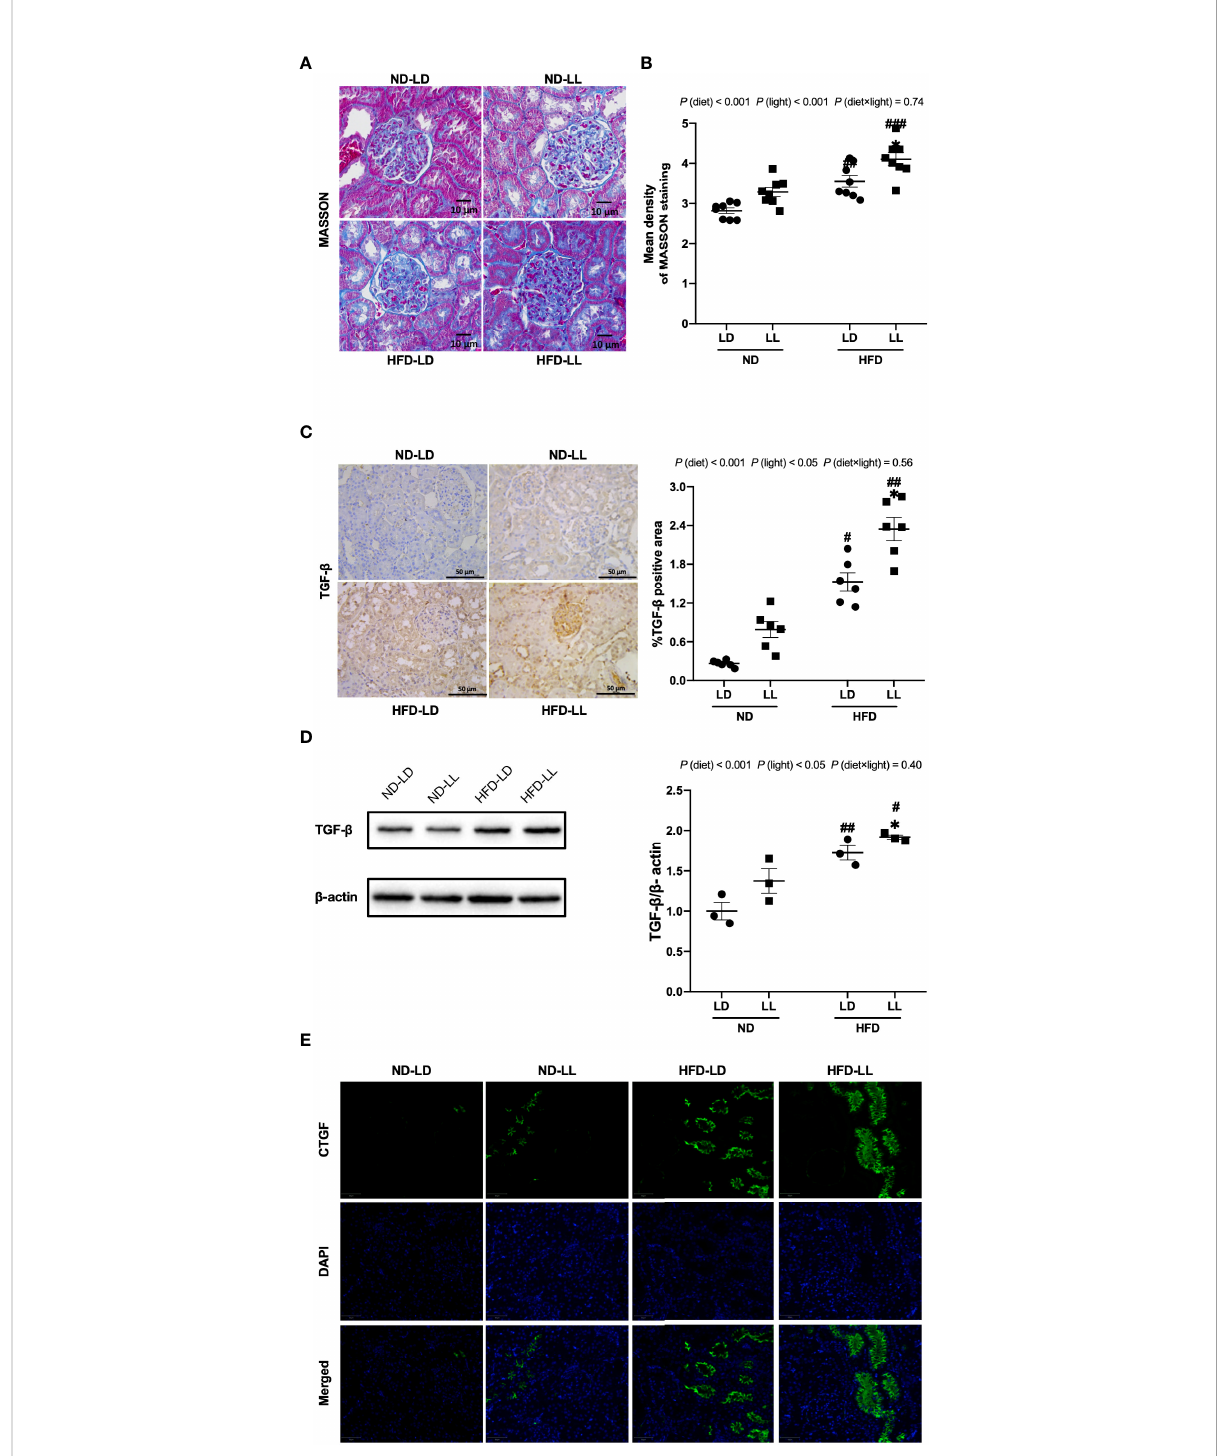
FIGURE 4 Effects of constant light on renal fi brosis in rats. (A) Renal masson ’ s trichrome staining (40×). Scale bar=10 m m. (B) Densitometric analyses of Masson ’ s trichrome staining. (C) IHC staining of renal TGF- b and semi-quanti fi cation analysis. (D) Western blot assays of TGF- b expression in kidney tissues. (E) Immuno fl uorescence staining of CTGF in kidney tissues. Values represent mean ± SEM (n=8 for B , n=6 for C , n=3 for D ). Differences were determined using a two-way ANOVA followed by a Bonferroni post hoc analysis. # p <0.05, ## p <0.01, ### p <0.001, vs. ND counterpart. * p <0.05, vs. LD counterpart. p (diet), main effect of diet; p (light), main effect of light; p (light × diet), interaction effect of light and